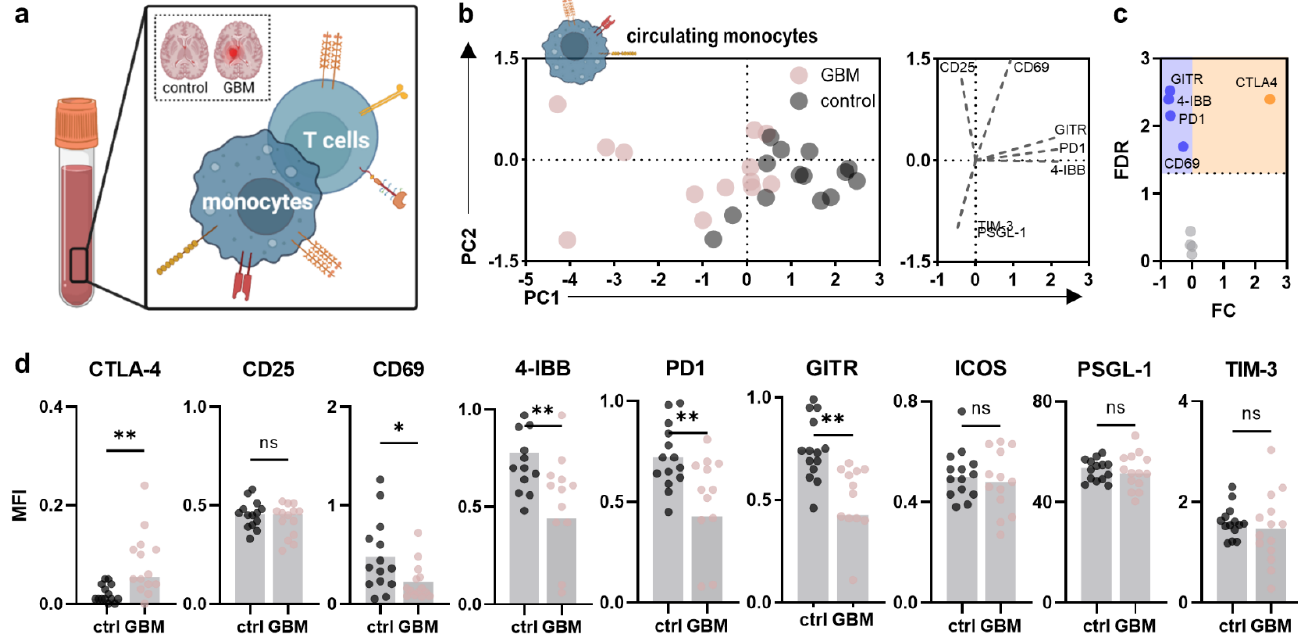
Figure 2. Alterations in the peripheral myeloid immune compartment of glioblastoma patients compared to healthy controls. ( a ) schematic overview of immunophenotyping analysis of circulating monocytes and T cells in the present study; ( b ) principal component analysis (PCA) calculated from marker expression profiles of circulating monocytes in age- and sex-matched healthy control participant (control) and glioblastoma patient (GBM)-derived PBMC showing PC scores ( left ) and loadings ( right ); ( c ) volcano plot showing significantly (dotted line, p < 0.05) up- (orange) and downregulated (blue) markers on circulating monocytes of glioblastoma patients compared to healthy individuals; ( d ) mean fluorescence intensities (MFI) of CTLA4, CD25, CD69, 4-IBB, PD1, GITR, ICOS, PSGL-1, and TIM-3 analyzed on circulating monocytes in glioblastoma patients and healthy individuals’ PBMC. Bar graphs show mean ± standard deviation of the mean (SEM). Statistical analysis was performed using paired t -test (* p < 0.05, ** p < 0.01). ns = non-significant. ctrl = healthy control participants. GBM = glioblastoma patients. PC = principal component. FC = fold change. FDR = false discovery rate.